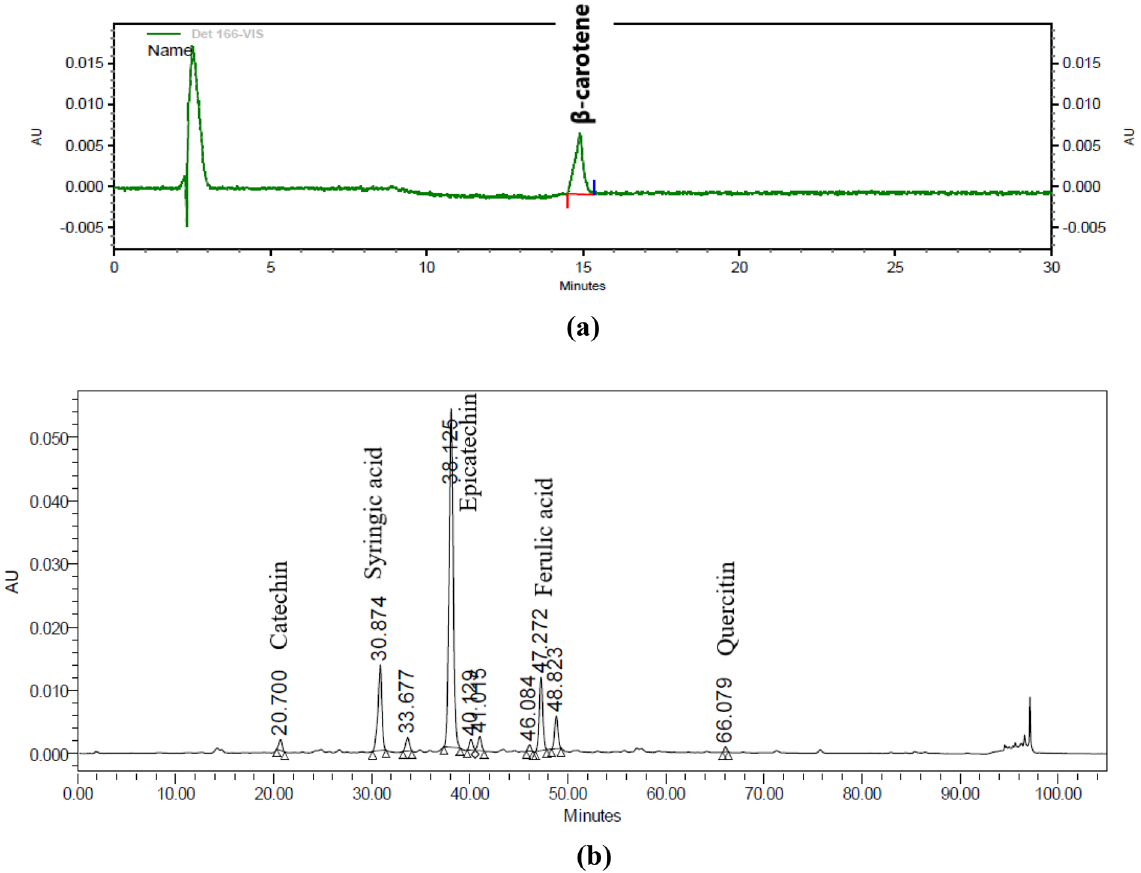
Figure 5. Characterization of ( a ) carotenoids and ( b ) phenolics using